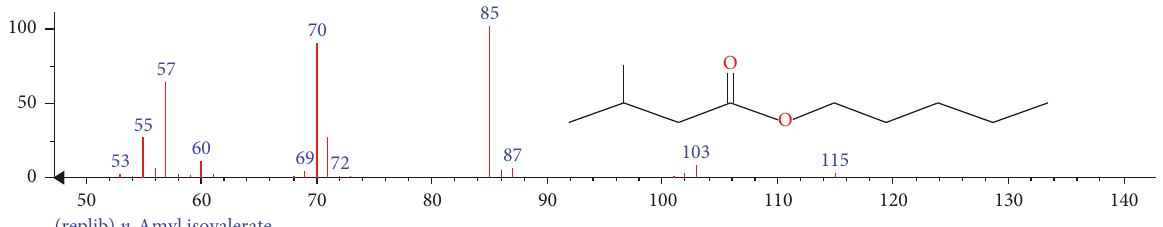
Figure 7: Mass spectrum of compound n -amyl isovalerate of whole plant hexane fraction of Achillea wilhelmsii (WHFAW).